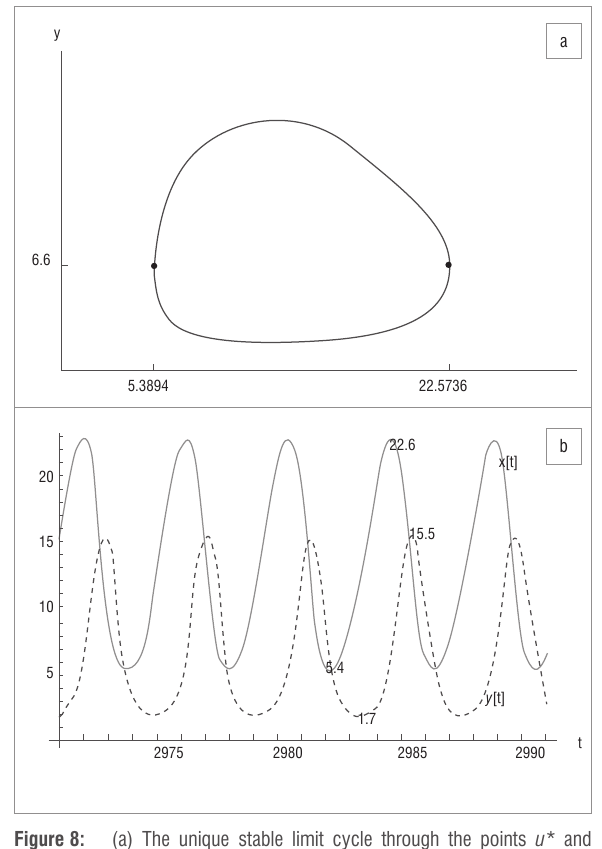
The limit cycles for these values of K are shown in Figure 10, but should not be confused with the typical periodic solutions of the traditional predator–prey model.